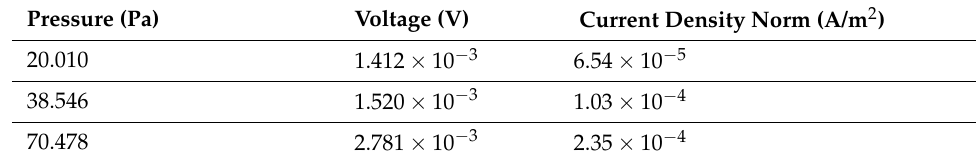
Table 10. Values of voltage and current.